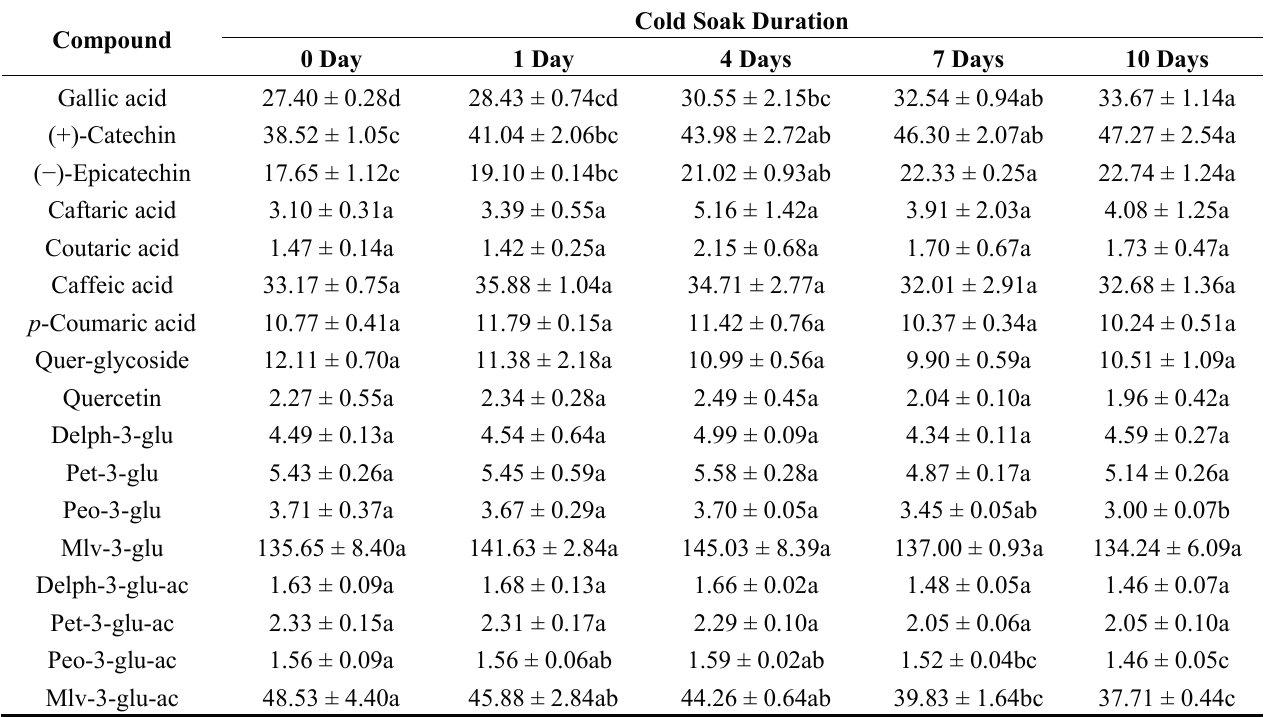
Figure 3. Tannin concentrations in treatments with different CS durations during CS period and active fermentation, as determined by the Skogerson–Boulton model (n = 3). The end of CS for 1, 4, 7, and 10 days of CS treatments are marked as a dash line at 39, 111, 183, and 255 h, respectively. Table 3. Concentration of phenolic compounds (mg/L ± SD) in finished wines made with different CS